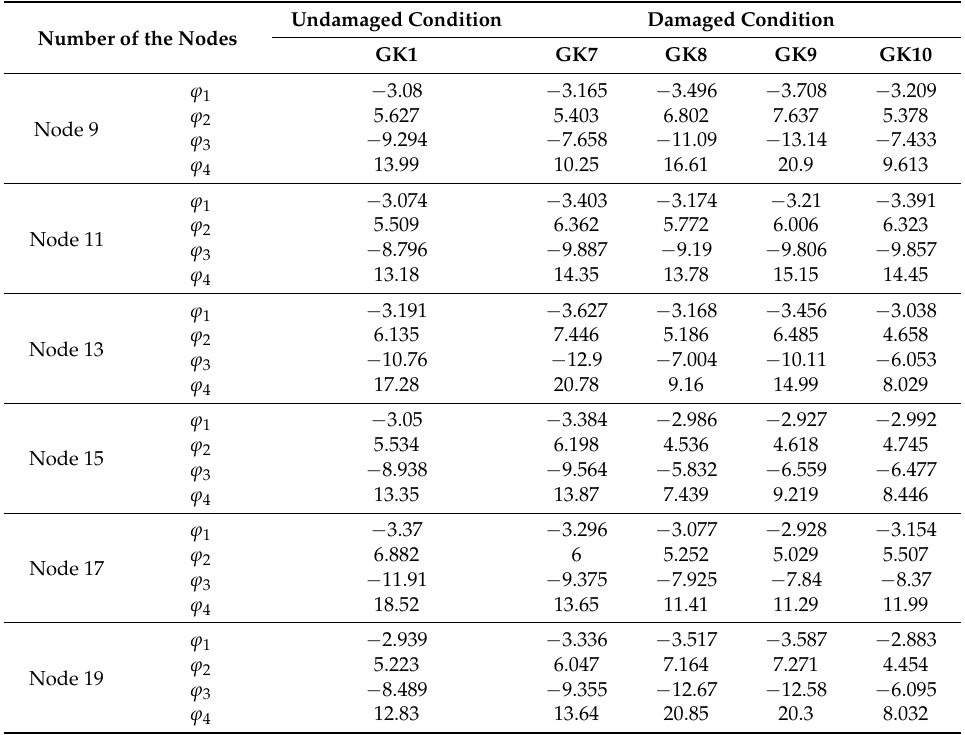
Table 5. A comparison of auto-regressive (AR) model coefficients between the undamaged condition and damaged